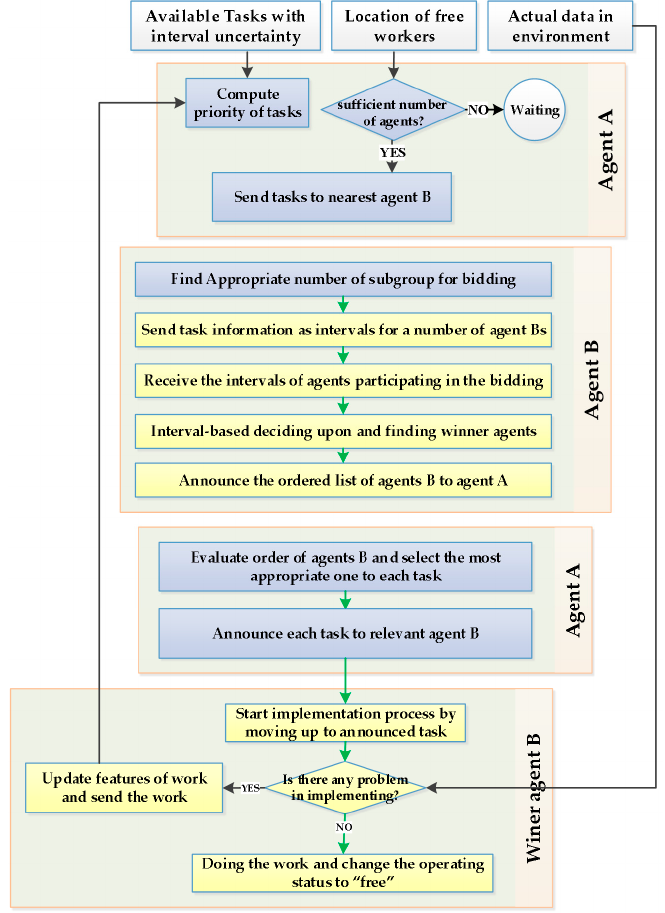
Figure 3. The process of assigning a set of tasks to a set of agents despite uncertainty in the